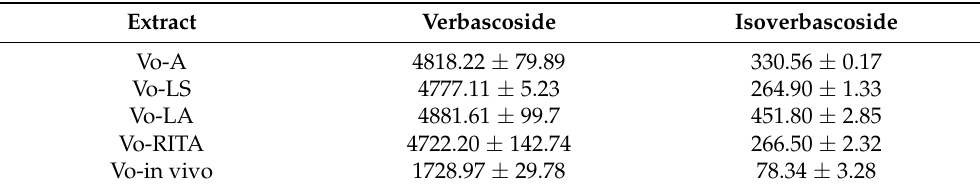
Table 2. Verbascoside and isoverbascoside concentrations (mg/100 g DW ± SD) measured in extracts from V. officinalis in vitro biomass and from plant